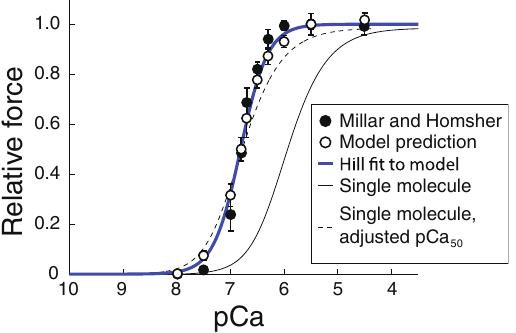
Figure 5. Strong-binding activation is necessary and sufficient to fit fiber data with the model. If strong-binding activation can be neglected, then the isometric force developed by a muscle fiber, which is proportional to the number of strongly bound myosin, should be described by the same curve as single molecule data. The response of a single myosin molecule to calcium (thin black line, pCa 50 = 5.96, α = 1.4 ± 0.3, mean plus/minus SD) is inconsistent with measurements of isometric force as a function of Ca ++ 18 (filled circles, error bars show SEM). Even when the pCa 50 of the single molecule curve is adjusted to match the measurements (dashed black line), the curve is not steep enough to fit the data. When strong-binding activation is included in the model (hollow circles, error bars show SD), simulation results are consistent with the measurements since a Hill fit to the model (heavy blue line, pCa 50 = 6.81 ± 0.03, α = 1.71 ± 0.19, mean plus/minus SD) also fits the measurements. ATP concentration 4000 μ